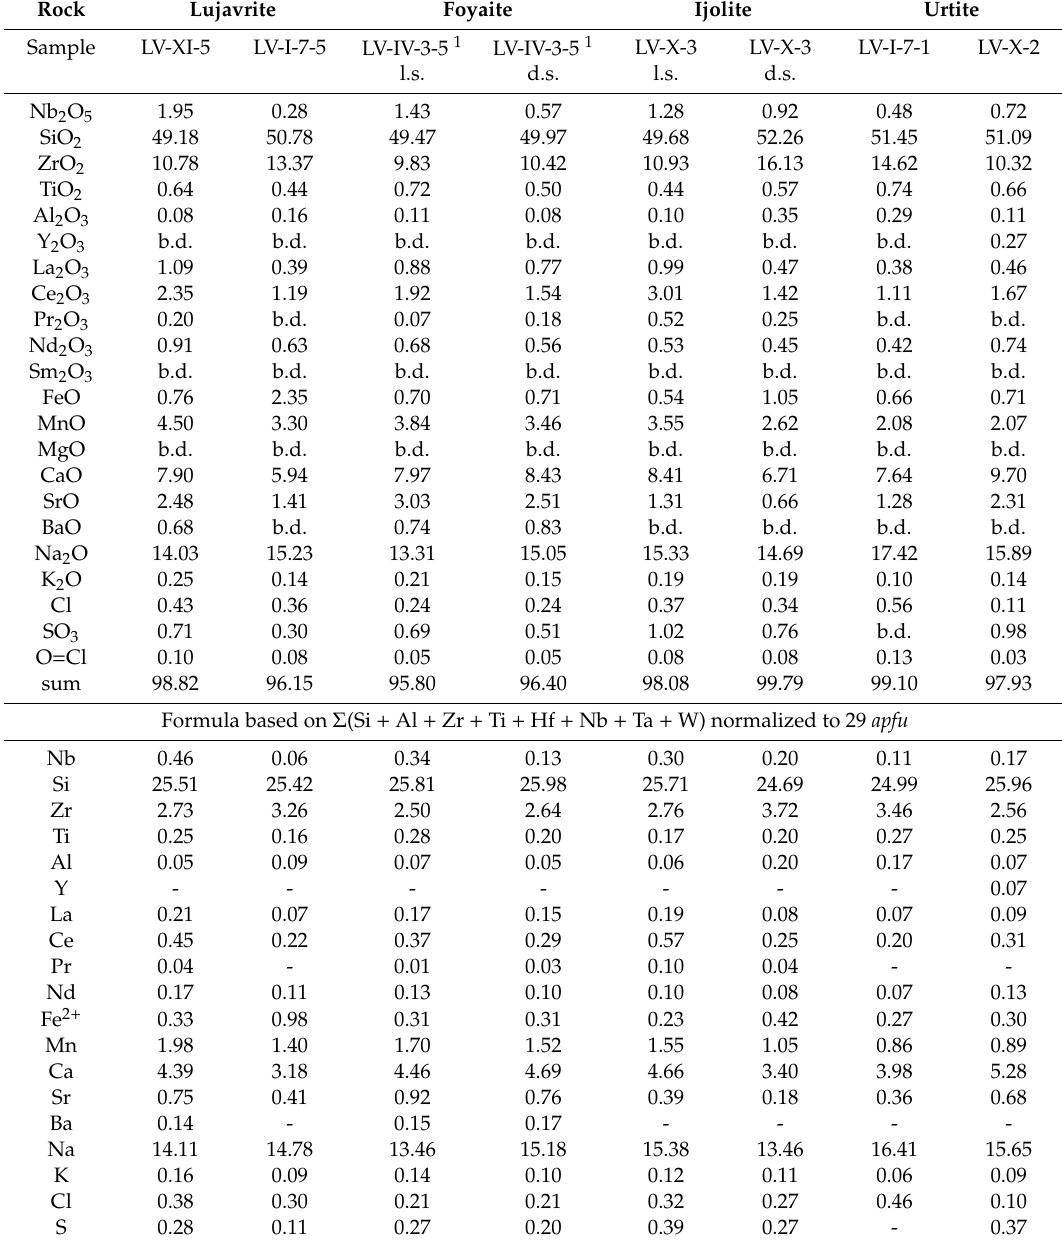
1 sector zoned grain on Figure 7b; l.s.—light sector; d.s.—dark sector; b.d.—below detection